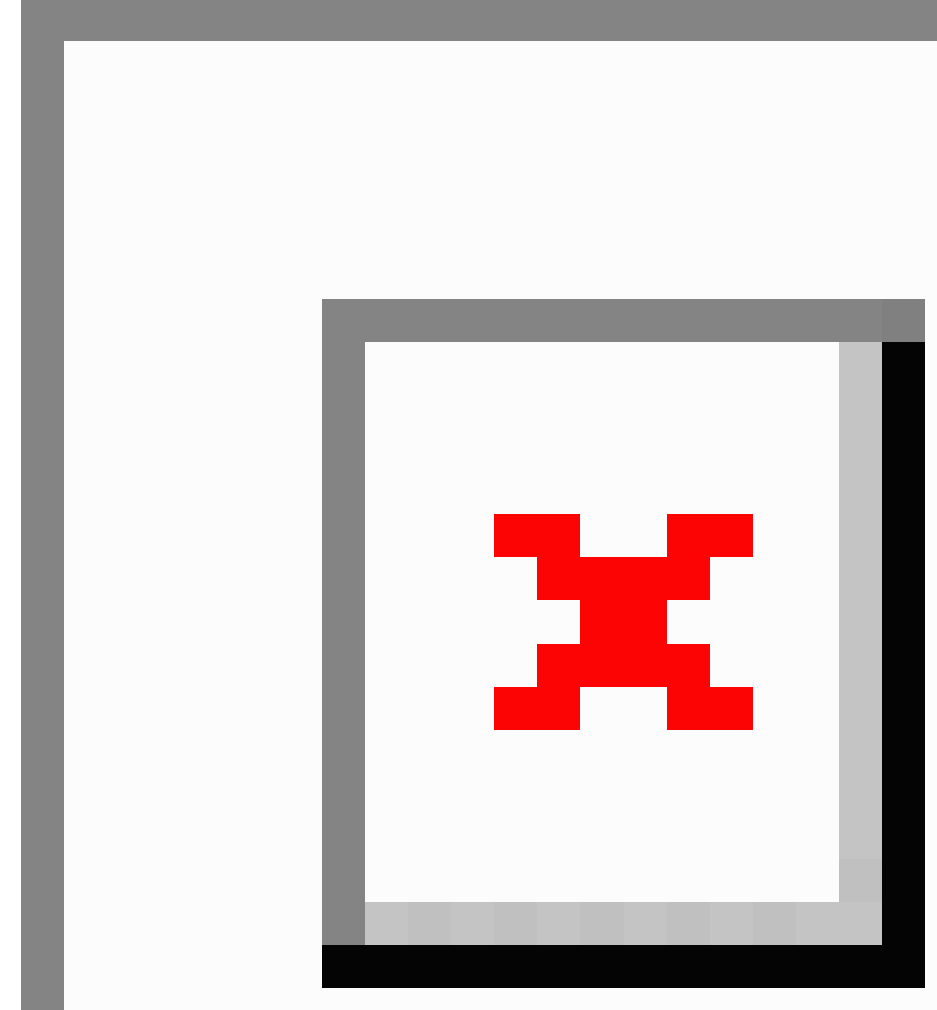
Figure 11. Mood Gym introduction